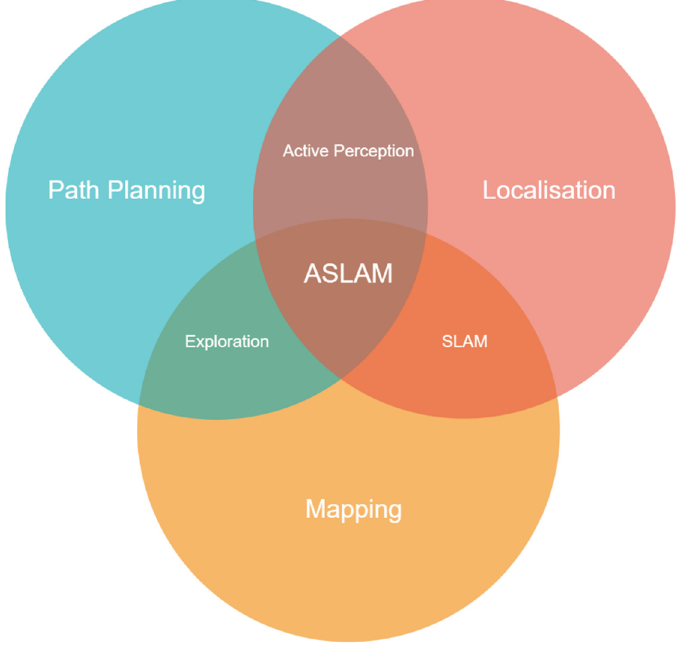
Figure 1. Components that form the Active Simultaneous Localization and Mapping (ASLAM) problem, expressed as set theory.